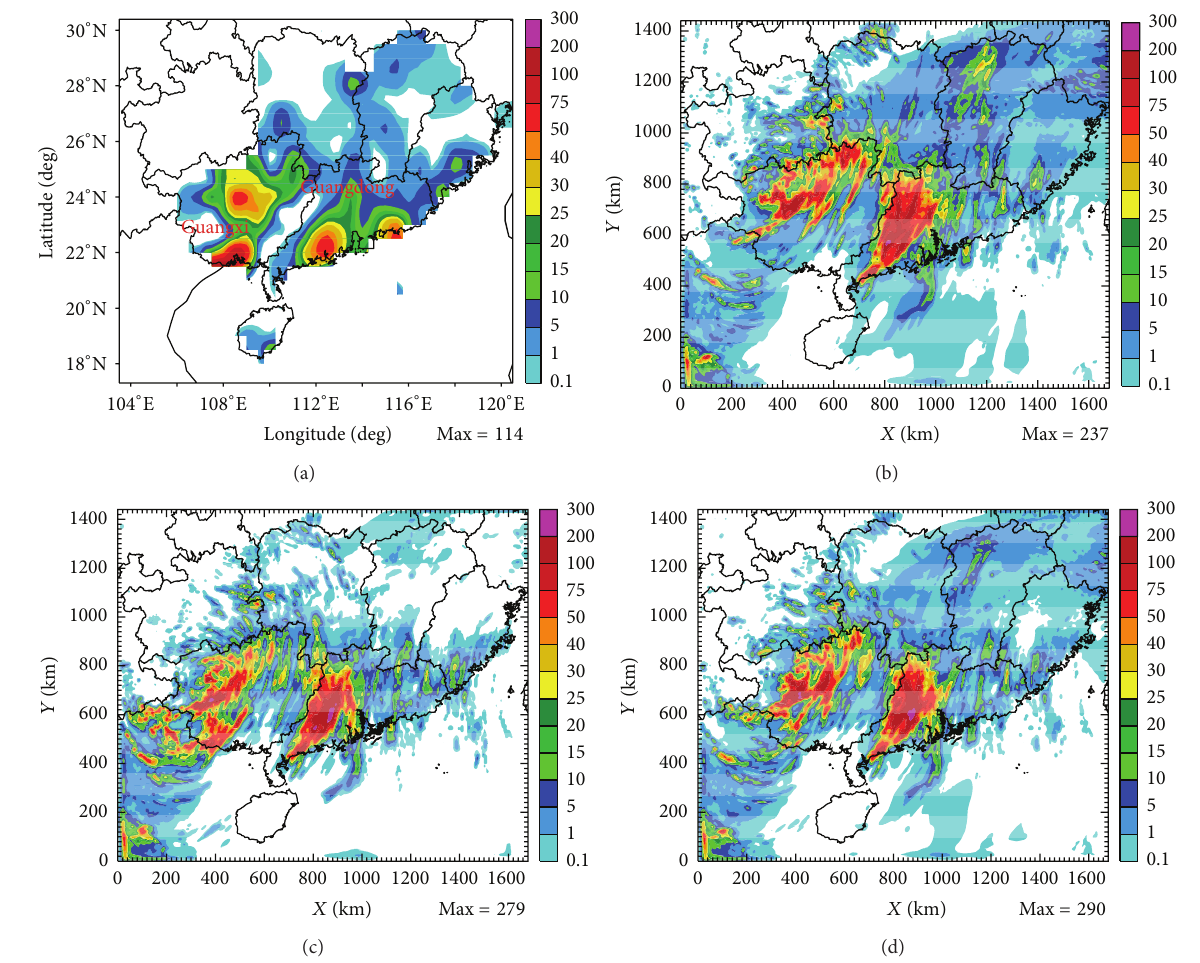
Figure 6: 12h accumulated precipitation from (a) observations, (b) CNTL, (c) RADSND, and (d) ALLDATA between 1200 UTC 29 June and 0000 UTC June 30, 2011 for case